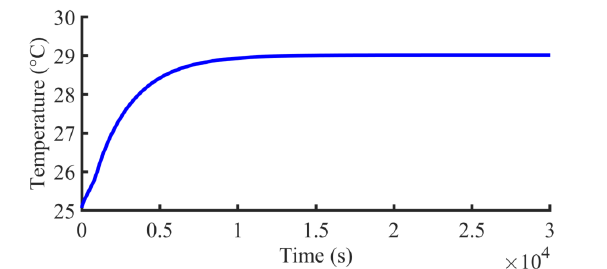
Figure 5. Temperature increase